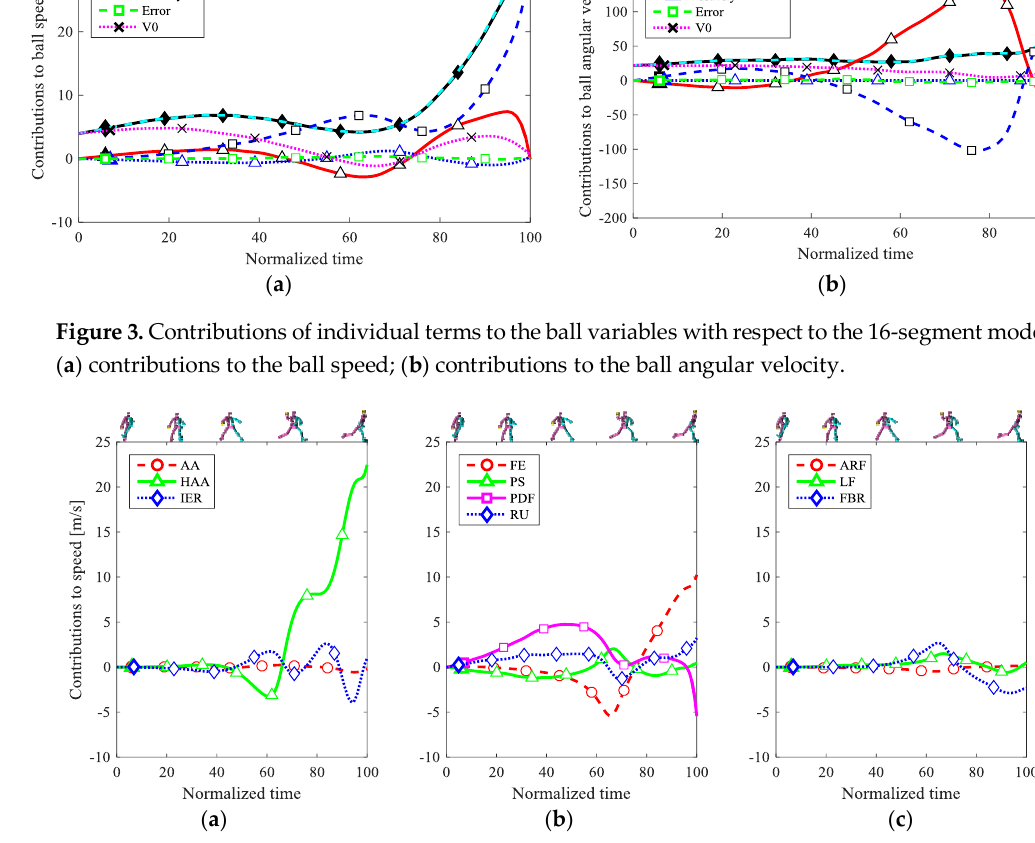
Figure 4. Time curves of major joint-torque contributors to the ball speed with respect to the 16- segment model considering generating factors of the MDT: ( a ) contributions of shoulder joint torques; ( b ) contributions of elbow and wrist joint torques; ( c ) contributions of torso joint torques. The legends in the figures are as follows, PS: pronation/supination; RU: radial/ulnar rotation; ARF: ante/retro flexion; LT: lateral flexion; FBR: forward/backward